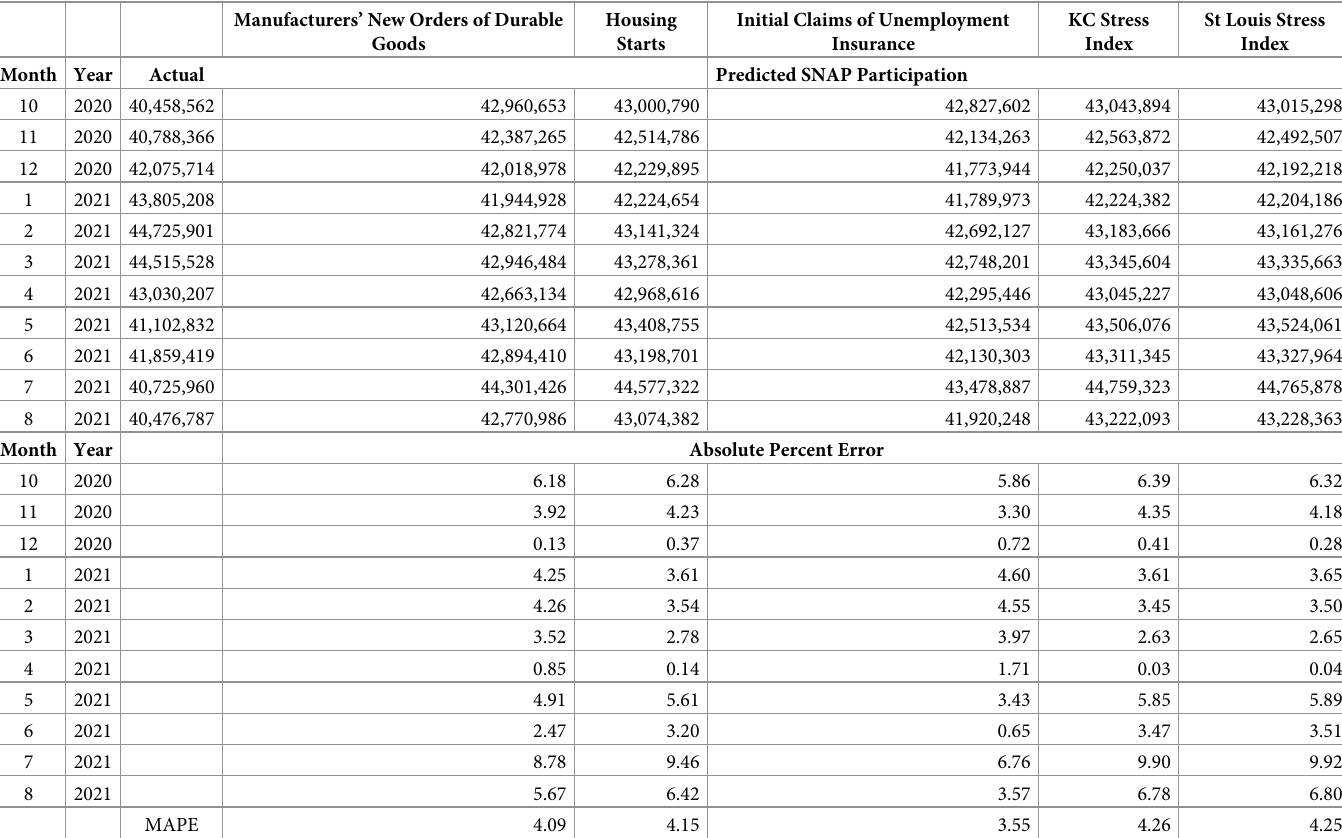
Table 3. Out-of-Sample predictive ability of the distributed lag models concerning SNAP participation by macroeconomic factor. Manufacturers’ New Orders of Durable